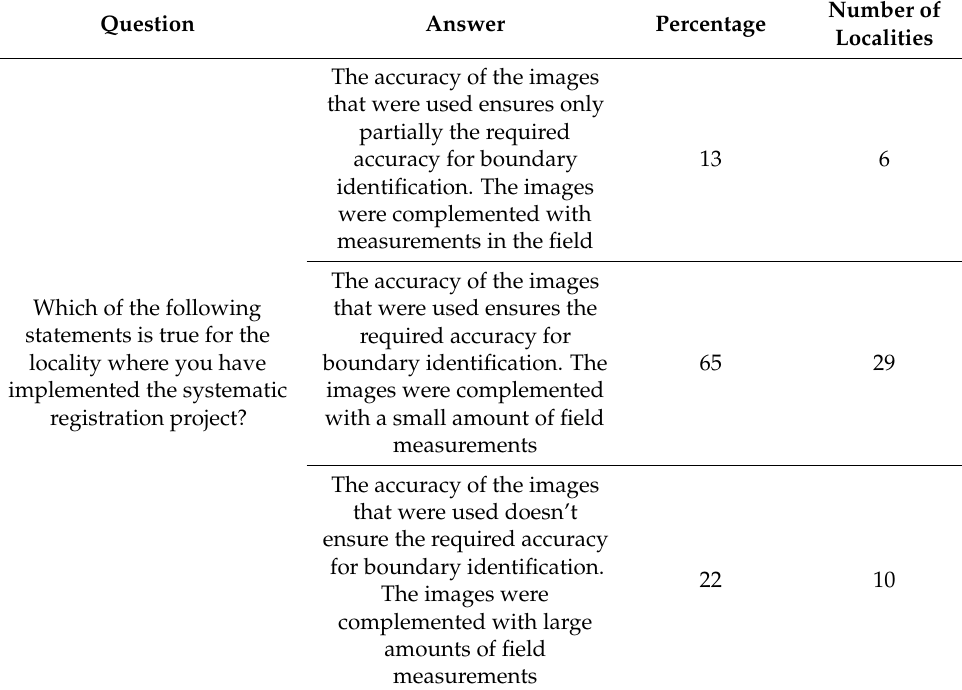
Table 6. Accuracy of images used and the amount of measurement that was necessary to complete the systematic land registration